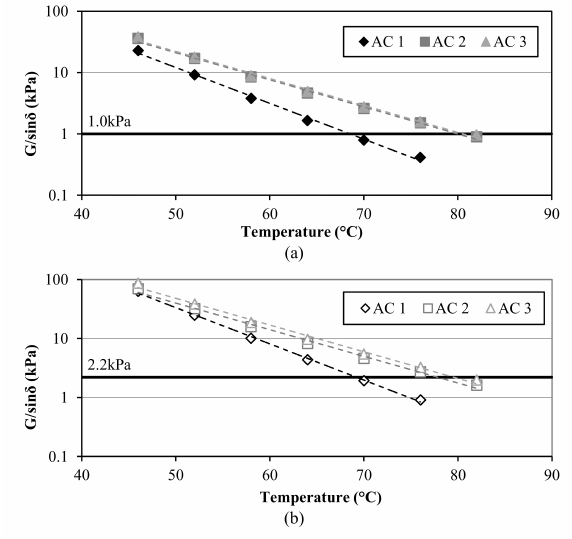
Figure 4: MSCR test results: (a) stress of 100 Pa and (b) stress of 3,200